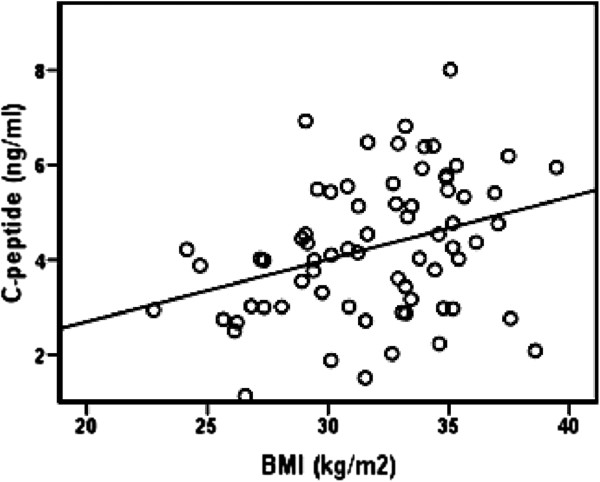
Correlation between BMI and C-peptide levels in T2DM patients (r = 0.330, p = 0.005, n =70).